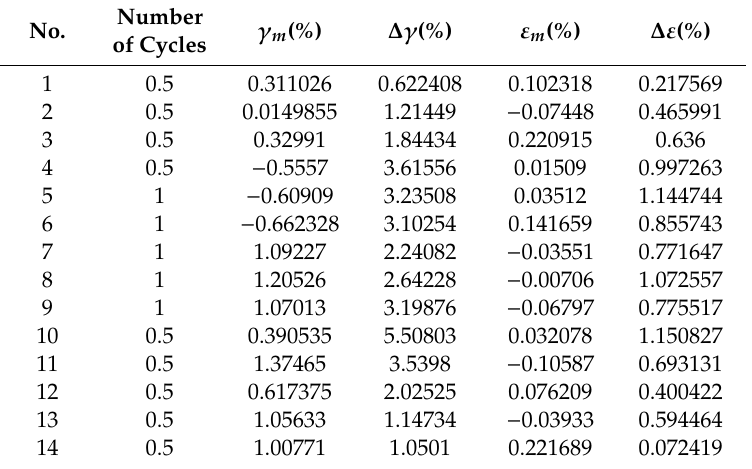
Table 5. Double cyclic rain flow counting results of the maximum damage critical plane of NWB_2.